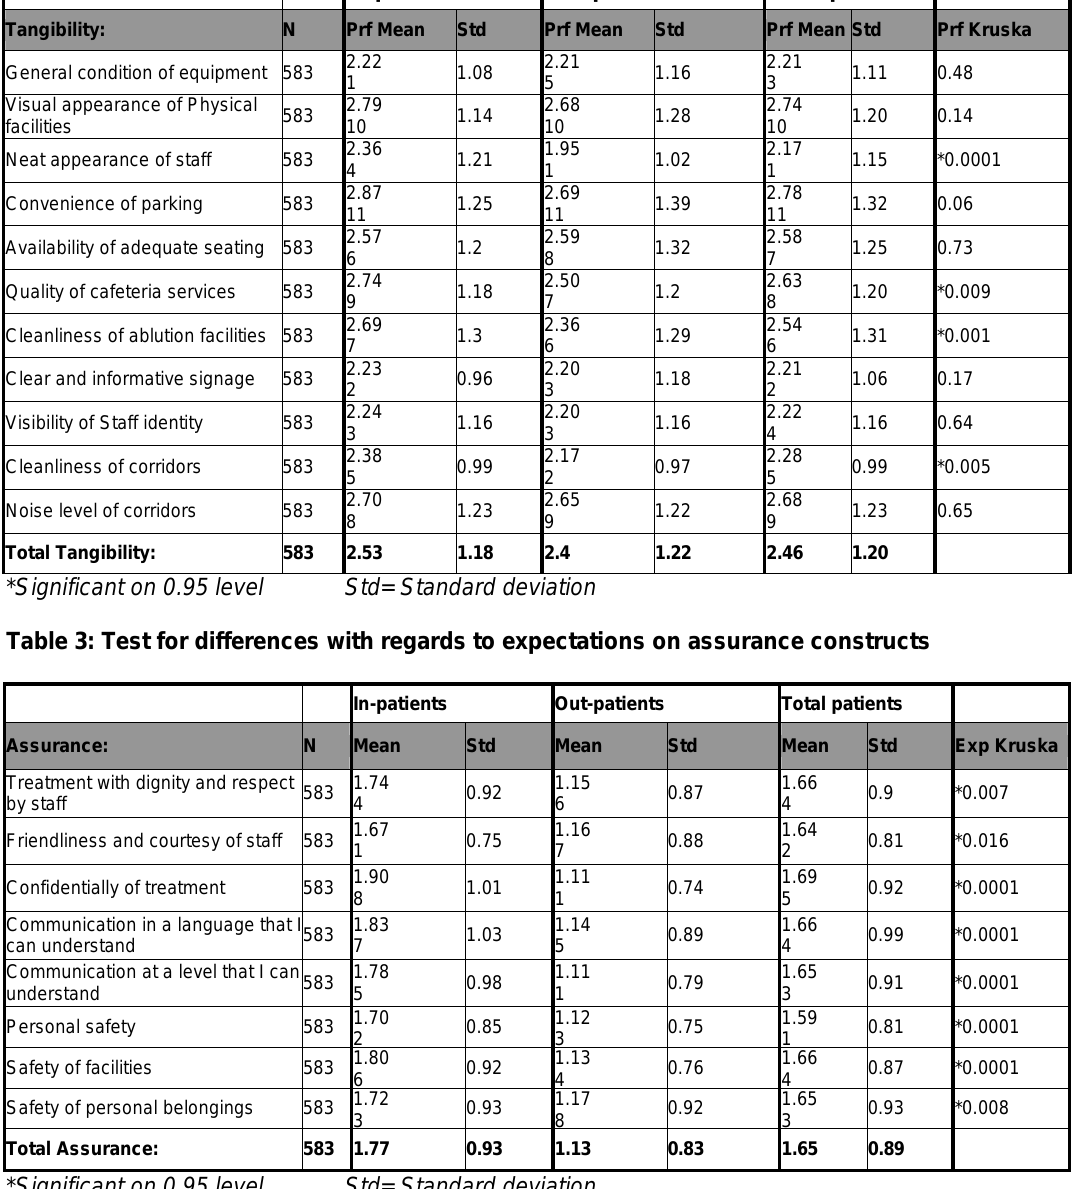
Table 2: Test for significant differences with regards to perceived performance on tangibility constructs In-patients Out-patients Total patients